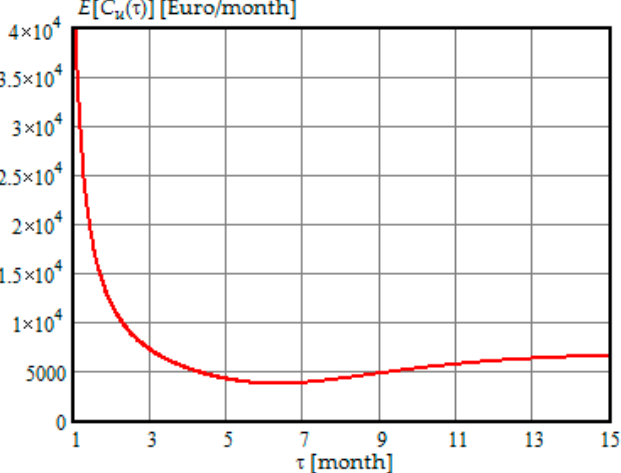
Figure 10. The dependence of the expected cost of maintenance per unit of time on the periodicity of preventive maintenance. preventive